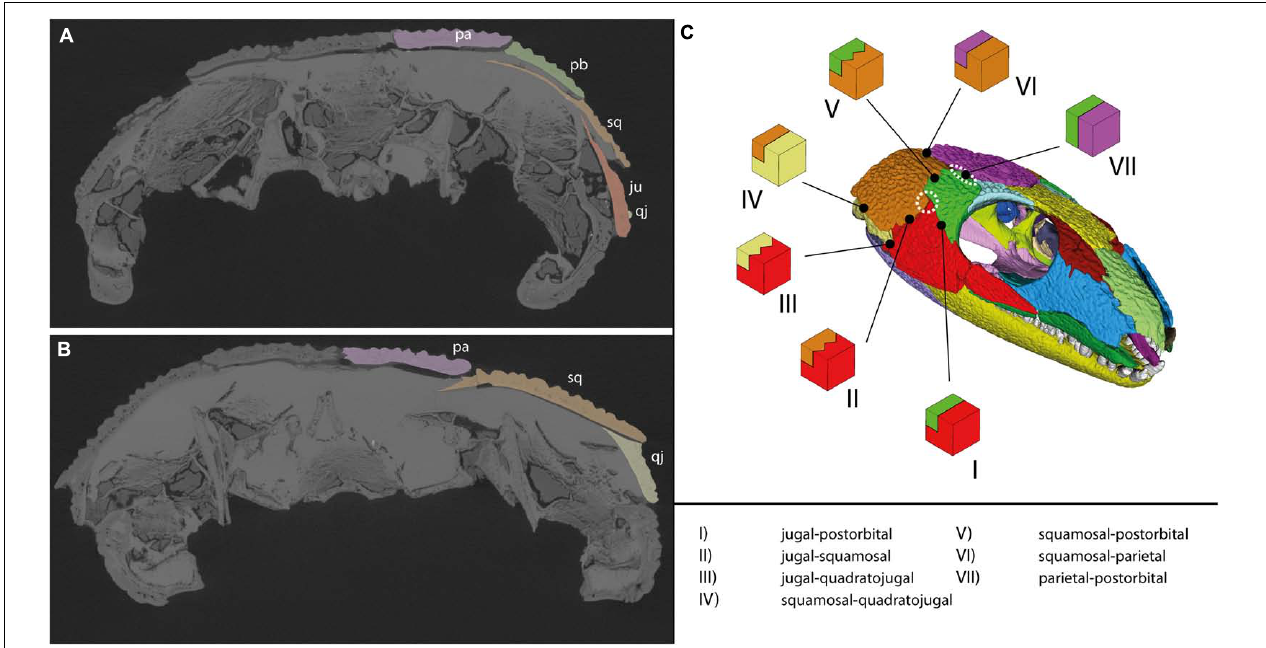
FIGURE 13 | Cross section through the temporal region of OMNH 44816 in posterior view highlighting the internal contacts of the dermal bones. (A) Anterior temporal region; (B) posterior temporal region. (C) 3D view on the dermal sutures in the temporal region of OMNH 44816. Dashed lines indicate potentially weak areas that could correspond to temporal openings in other early